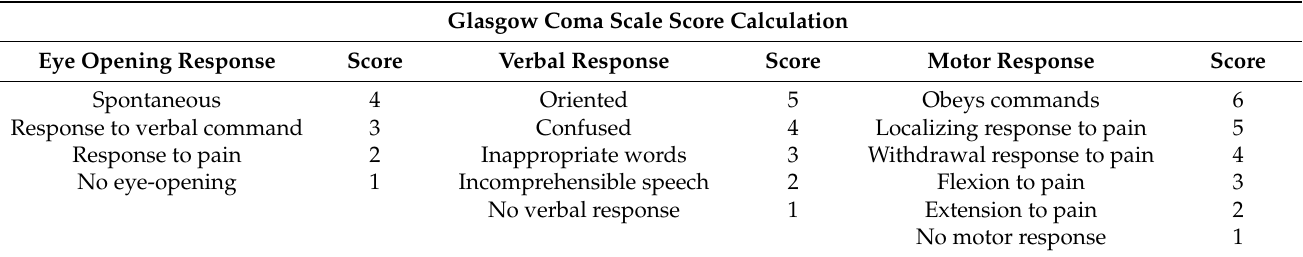
Table 1. The definitive details of calculation of Glasgow coma scale score and description of Glasgow coma scale (GCS) and post-traumatic amnesia (PTA) classification systems employed to categorize traumatic brain injury.